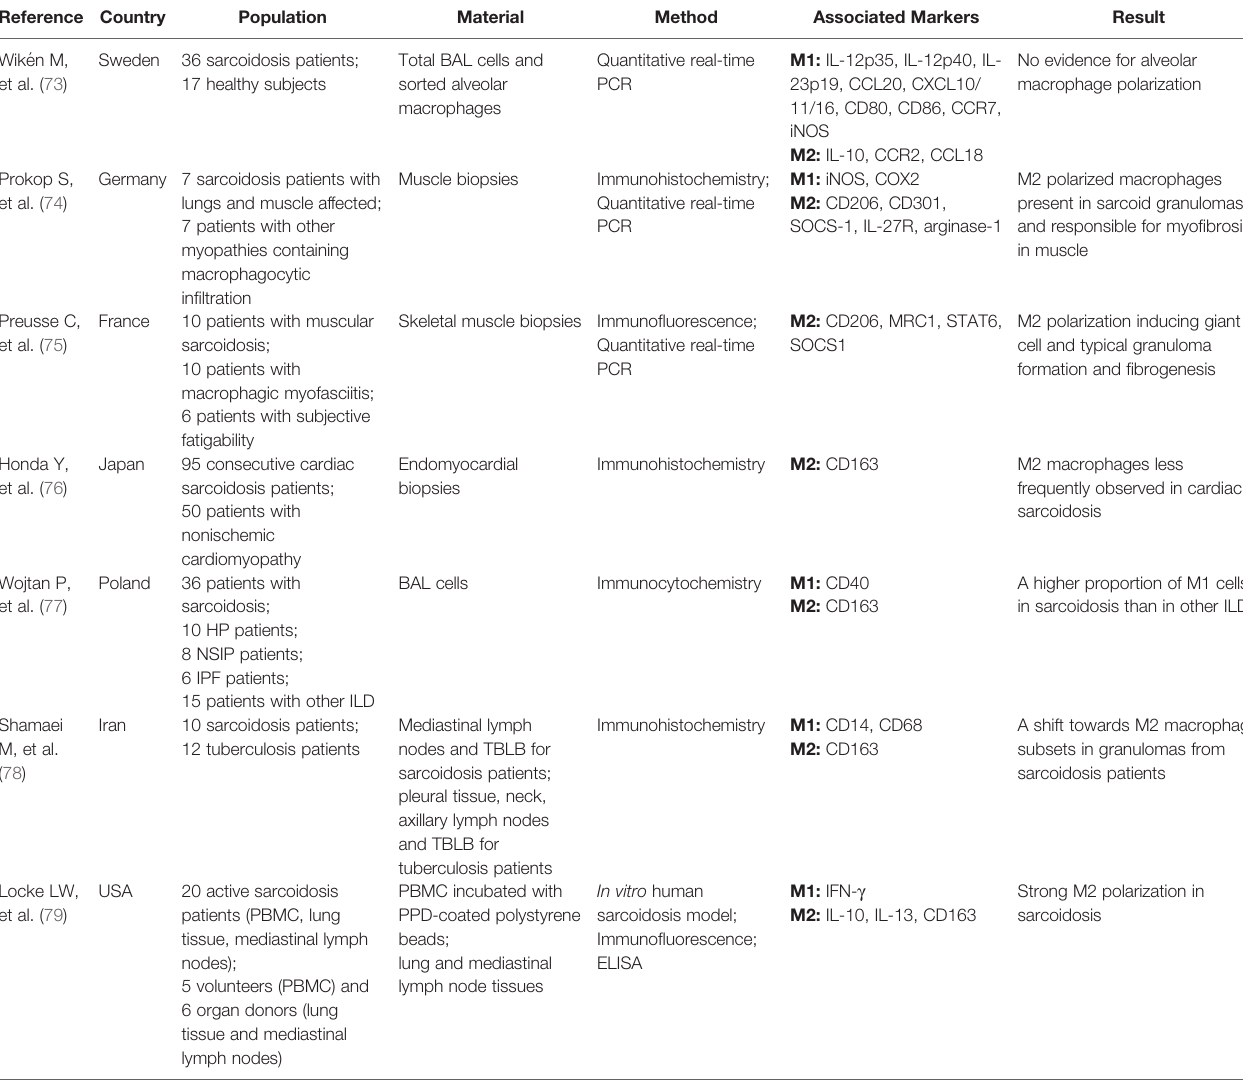
TABLE 1 | Studies on macrophage polarization in sarcoidosis. Reference Country